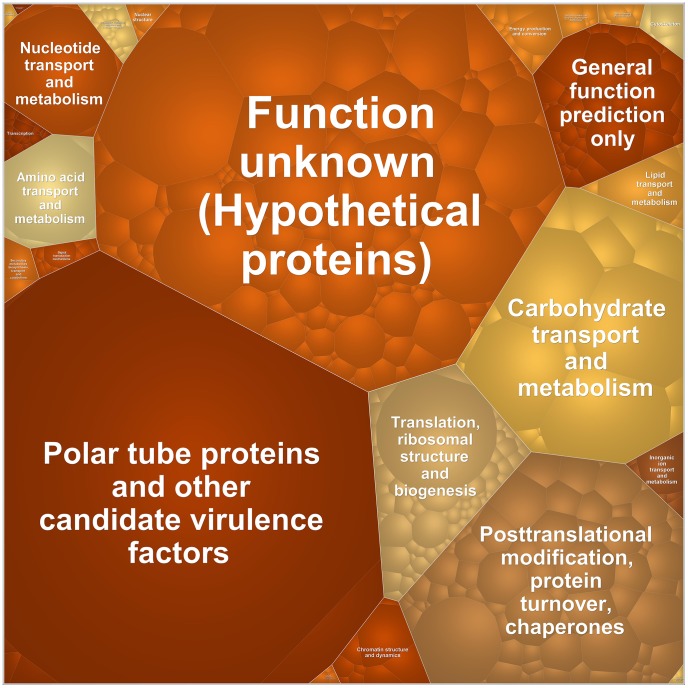
Major functional categories of proteins detected in the proteomics analysis of T. hominis spores.Voronoi treemap [132] illustrating the major COG categories, complemented with an ad hoc category for putative T. hominis “virulence factors”, detected in the spore proteomics data. Each functional category and individual protein, for a total of 484 proteins (Table S19), are represented by delineated cells. The area of the different cells is proportional to the relative abundance of the proteins according to spectral counts. The locus tag and protein annotation for each individual protein are illustrated in the Voronoi treemap shown in Figure S16. Protein annotation, including predicted signal peptides and transmembrane domains, semi-quantitative spectral counts and presence of homologues of the 484 proteins in the other 5 microsporidians analysed, are provided in Table S19.